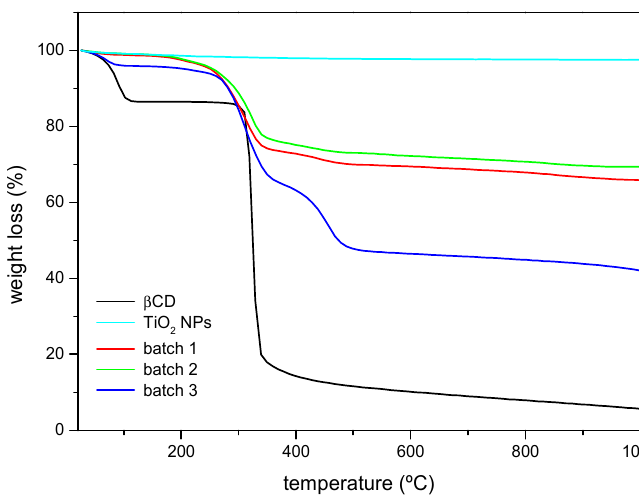
Figure 3. Thermogravimetric analysis (TGA) curves (% weight loss) corresponding to β CD, as-received TiO 2 NPs, and β CDTiO 2 NPs (batches 1, 2, and 3).